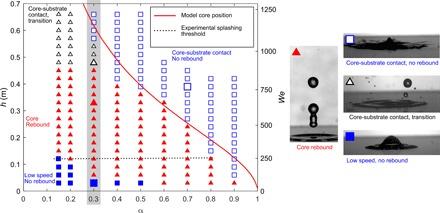
Map of the rebound behavior after impact on a hydrophilic surface as a function of the water volume fraction α and the impact height h (left axis) and Weber number We (right axis), for compound drops produced with the coaxial needle method.Closed squares, no rebound; closed triangles, rebound (core-shell rebound); open triangles, core-substrate contact, transition zone; open squares, core-substrate contact, no rebound. Shaded area: This region (α = 0.3) refers to the investigation detailed in Figs. 3 and 4. Magnified symbols correspond to the images on the right. The solid line indicates the height from which the water core can sink to the bottom of the drop, obtained by numerical integration of Eqs. 1 and 2. The We axis corresponds to α = 0.3 but is representative for all α since the dependence on α is small.